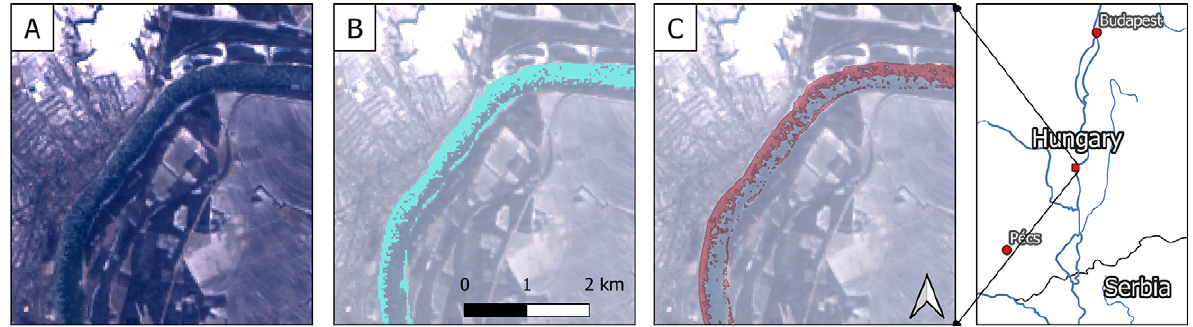
Figure 9. Validation of ice coverage derived from Sentinel-1 in 2017 on the Danube. Validation satellite image (Landsat 8 RGB432) (A), reference data derived by ISODATA clustering of Landsat 8 image (B), and ice coverage derived from Sentinel-1 satellite image (C). Sentinel-1 and Landsat 8 images were both acquired on January 22,